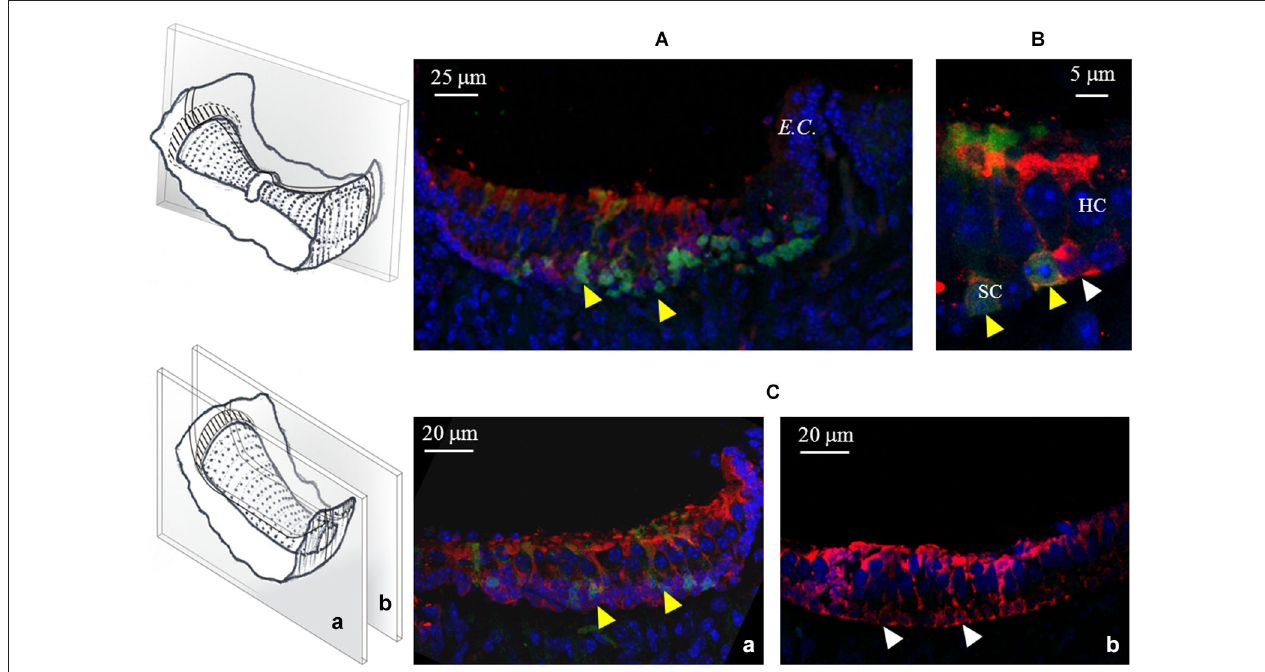
(yellow arrowheads) or GABA-only expression (white arrowhead) in three different supporting cells. (C) Confocal images from two longitudinal slices of a horizontal crista depicting the peripheral (a) and the central (b) zone. Most peripheral supporting cells co-express GABA and GAD67, while central supporting cells only express GABA. No GABA expression was ever found in hair